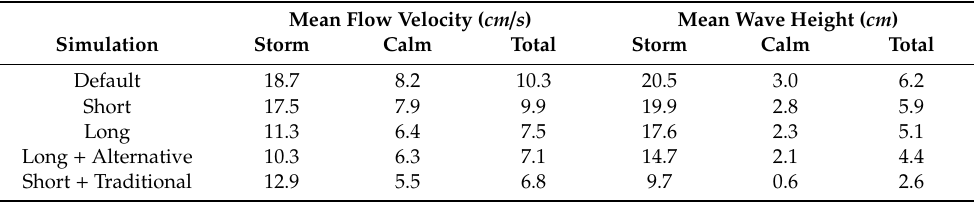
Table 2. Comparison of hydrodynamics within the whole study area for the various configurations of artificial structures. Based on data with a two-hour interval. Storm refers to the average conditions during the storms of 4–5 October and 28–29 October. The calm period is from 9 to 22 October. Total is for the whole simulated month.